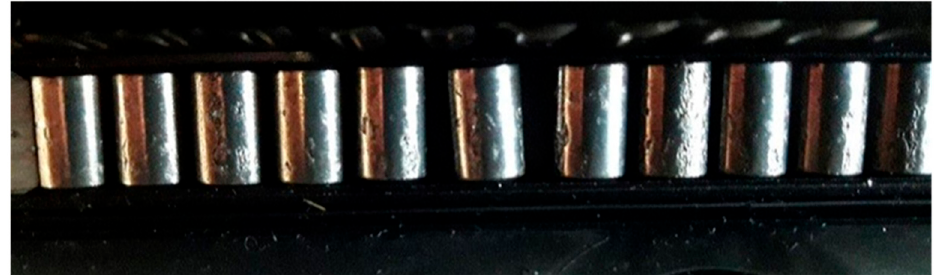
Figure 2. Pitting of rolling elements of linear rolling system.